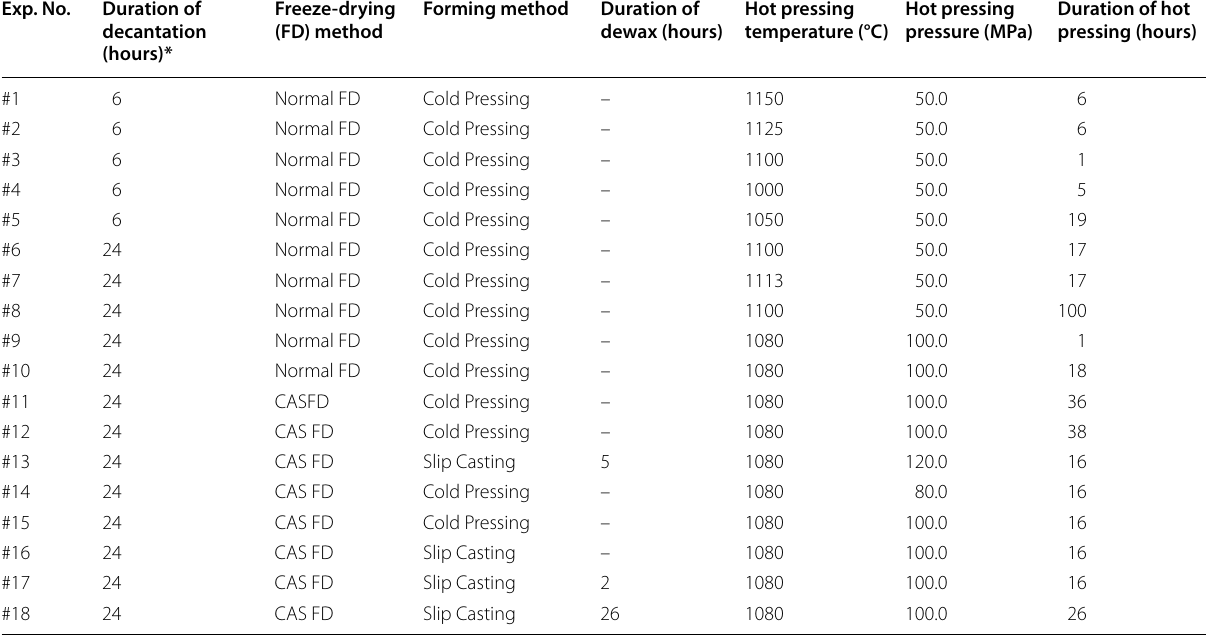
*Powders after 6 h decantation are smaller than 2 µm, and those after 24 h decantation are smaller than 500 nm